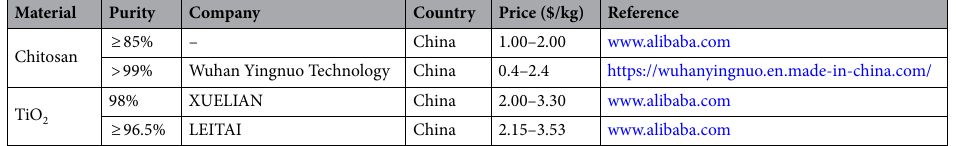
Table 6. Cost of chitosan and TiO 2 nano-powder.